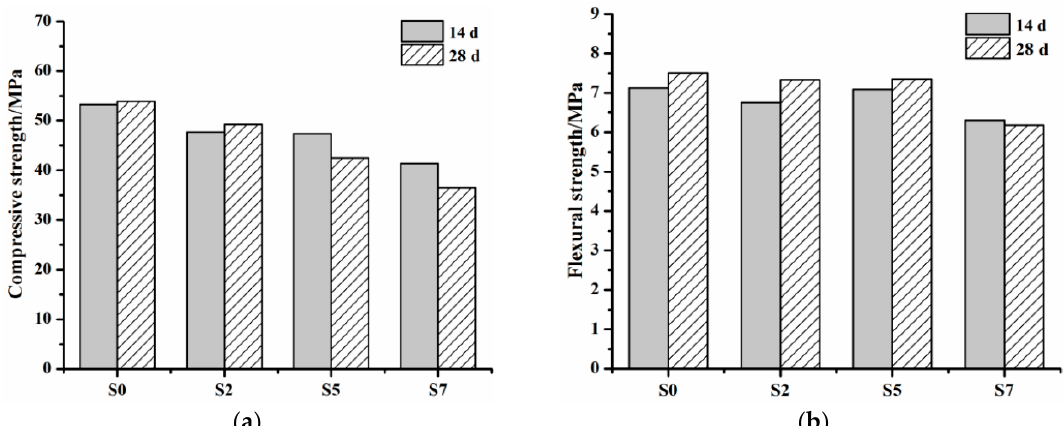
Figure 9. Compressive strength and flexural strength of mortar groups at 14 and 28 d ages. ( a ) Compressive strength of mortar groups at 14 and 28 d ages; ( b ) Flexural strength of mortar groups at 14 and 28 d ages.